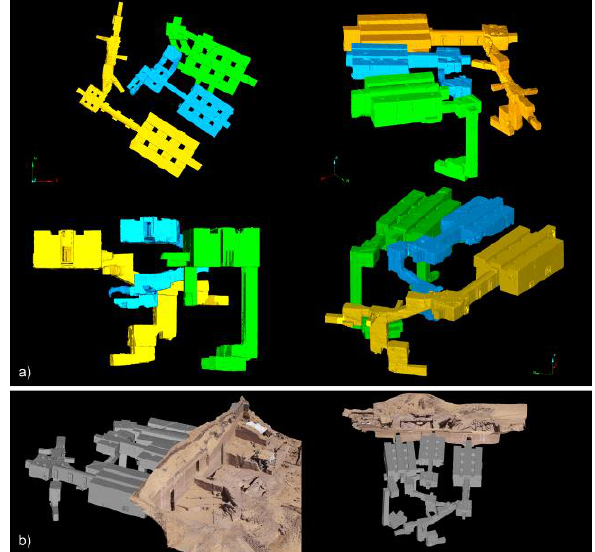
Figure 7. a) Views of the 3D models obtained: QH31 in yellow, QH32 in blue and QH33 in green; b) views of the 3D models of the tombs with the exterior model